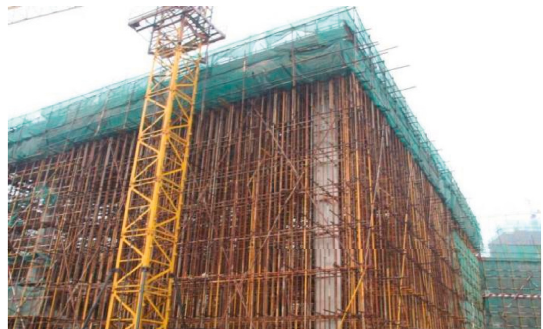
Figure 1: Excessive consider of safety leads to a high density of the support.